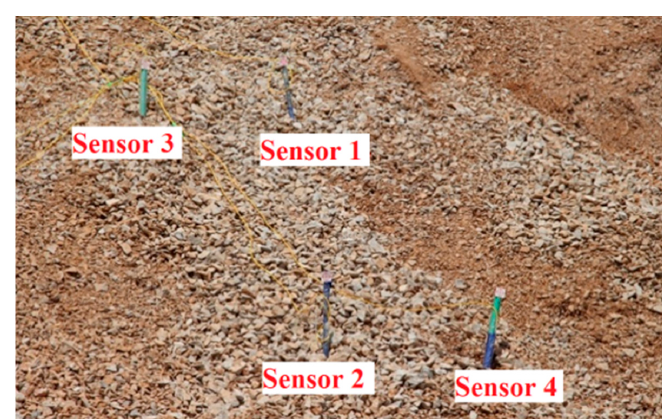
Figure 9. Artificial hillock.